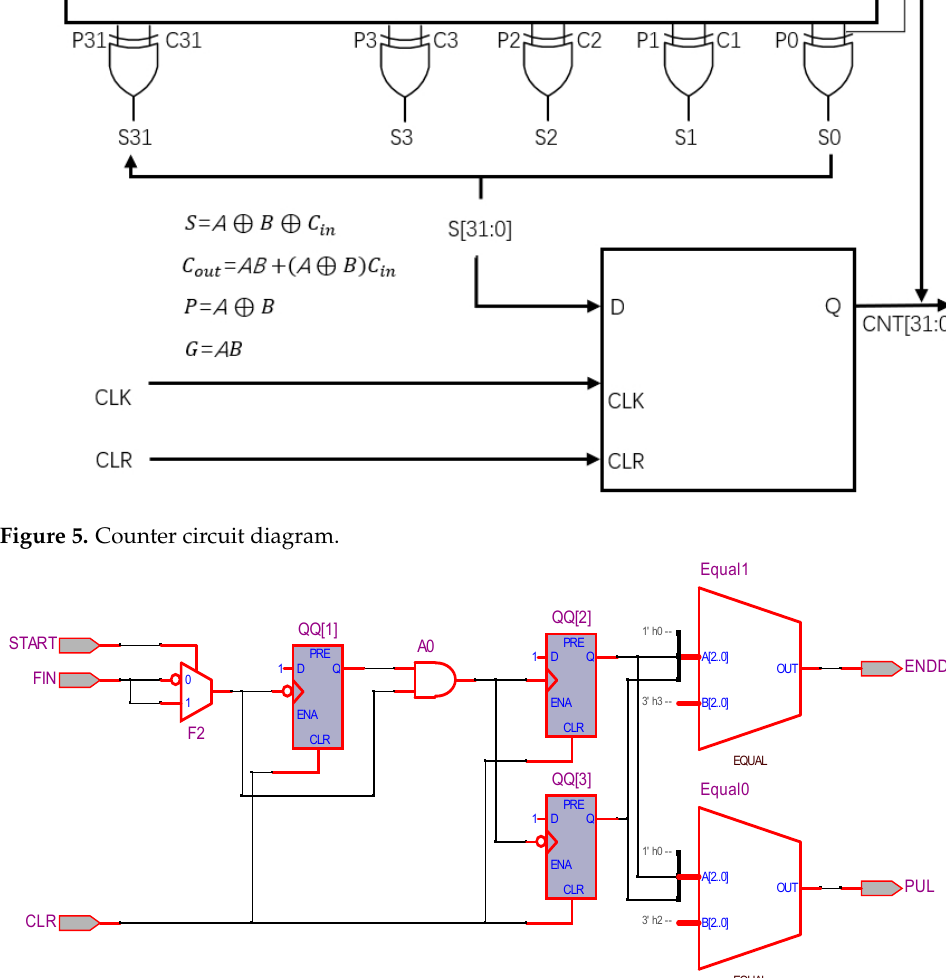
Figure 5. Counter circuit diagram.